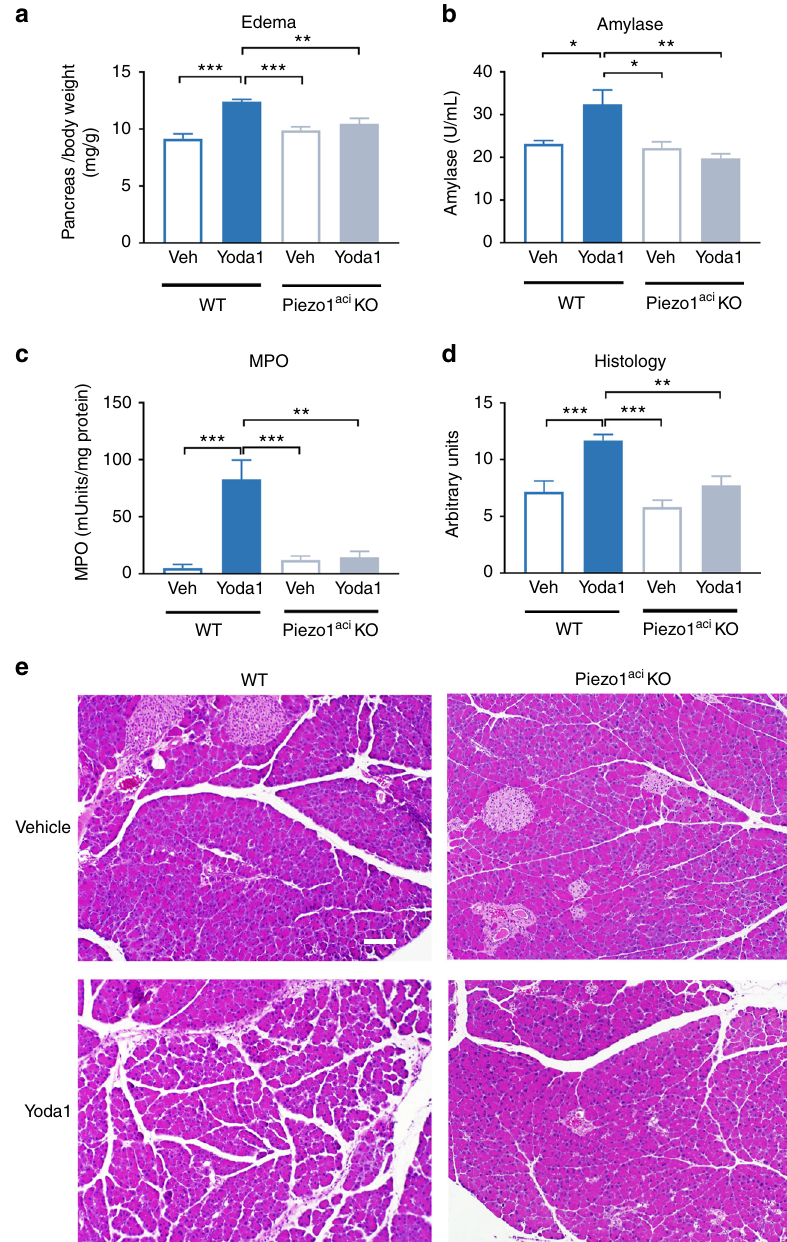
Fig. 5 The Piezo1 agonist Yoda1 induces acute pancreatitis in wild-type mice but not in mice with genetic deletion of Piezo1. Yoda1 at a dose of 0.4 mg/kg in 50 µ L (1.1 % DMSO; 4.8% ethanol; 94.1% buffered saline, pH 7.6) was infused into the pancreatic duct of WT or Piezo1 aci KO mice over 10min at pressures not exceeding 7 – 11 mmHg. Either vehicle or Yoda1 was infused. Tissues were harvested 24h post injection and analyzed for a pancreatic edema, b serum amylase, c pancreatic myeloperoxidase (MPO), and d histological scoring. n = 6 – 8 animals per group. Statistical analysis was performed by ANOVA with Tukey ’ s post-test. * P ≤ 0.05; ** P ≤ 0.01; *** P ≤ 0.001. e Representative images of pancreatic tissue stained with H&E are shown. Bar = 100 µ